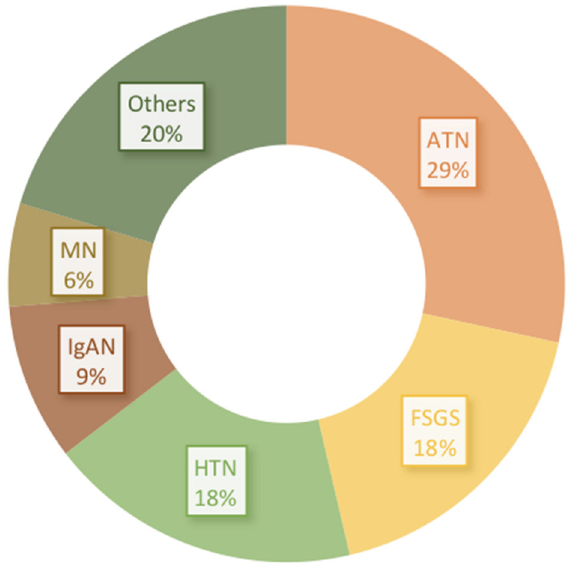
Figure 1. Kidney biopsy findings in a diabetic patient study from the Columbia Renal Pathology Laboratory, in 2011 [6]. Global frequencies including nondiabetic kidney disease (NDKD) alone and NDKD associated with diabetic nephropathy (DN). Focal segmental glomerulosclerosis